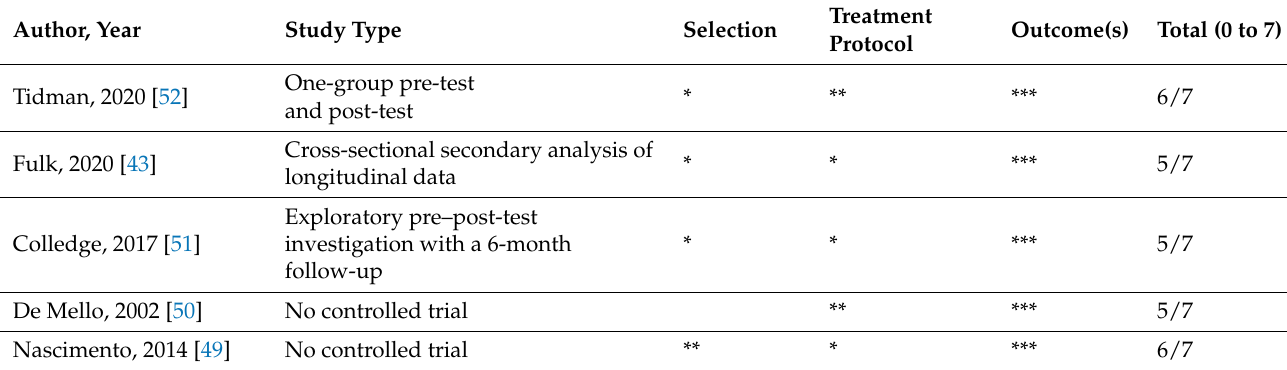
Table 2. Modified NOS scale scores of the included